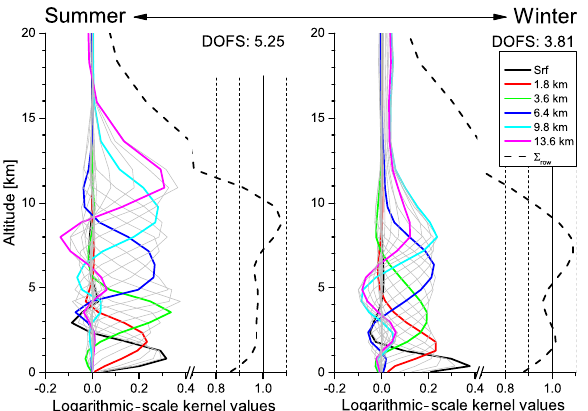
Figure 5. Same as Fig. 3, but for a typical winter and sum- mer observation above Lindenberg. Summer observation: 1 Au- gust 2008 08:39:01UT, satellite zenith angle 43.7 ◦ , precipitable water vapour 28.8mm; winter observation: 15 February 2008 09:54:30UT, 41.2 ◦ ,